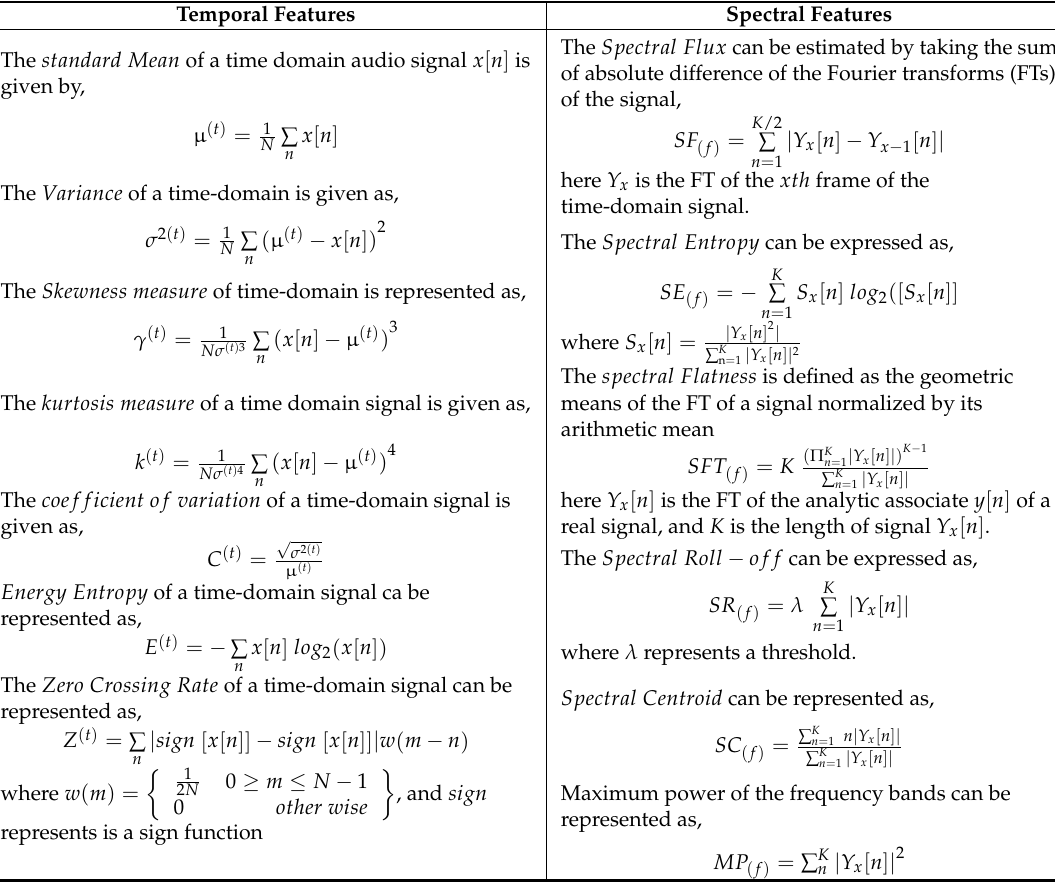
Table 1. Temporal and Spectral